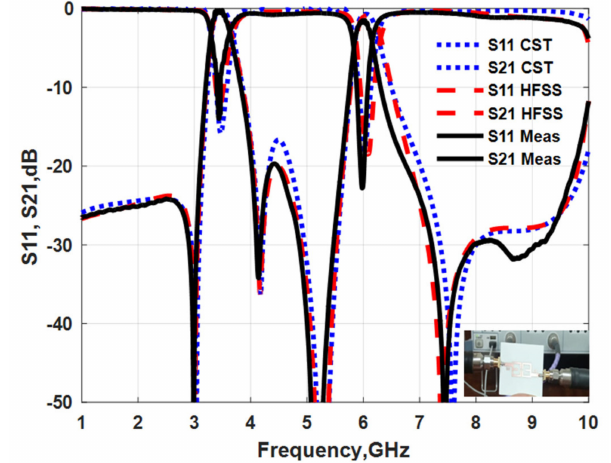
Figure 13. S 11 , S 21 simulated and measured performance of dual-band stub loaded OLR BPF with 0 ◦ feed and two spiral